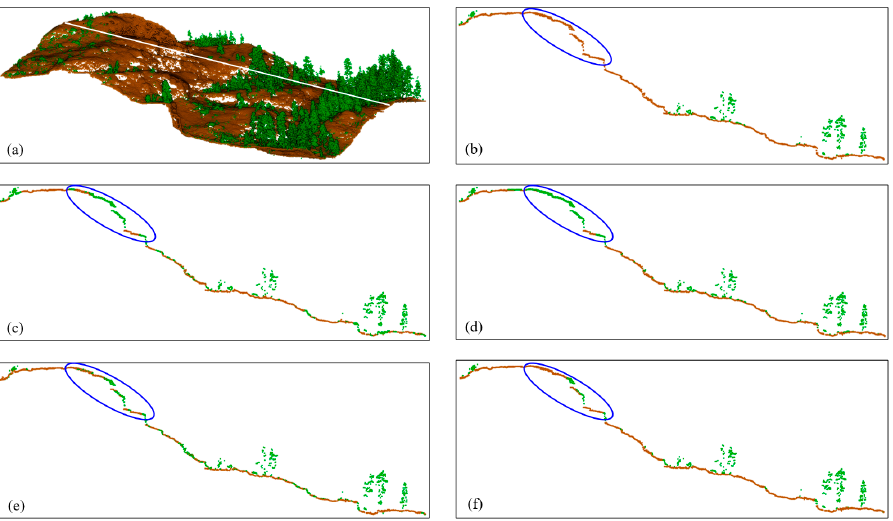
Figure 9. Qualitative comparison of ground filtering results in Site 4. ( a ) The 3D transect position (white line) in Site 4. The 3D transects of ground filtering results obtained by ( b ) human interaction, ( c ) MSF, ( d ) PMF, ( e ) CSF and ( f ) proposed method. Brown and green points represent ground and non-ground points, respectively. The content inside the blue ellipses indicates the terrain details ignored by the proposed method.